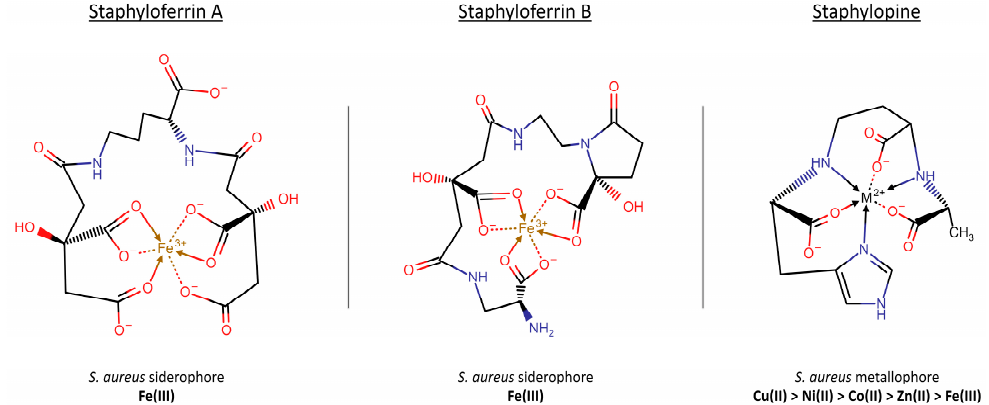
Figure 2. Structures of the three siderophores of S. aureus, adapted from Neumann et al. [106] on the basis of iron-bound models [46,47]. The chemical structures were drawn with